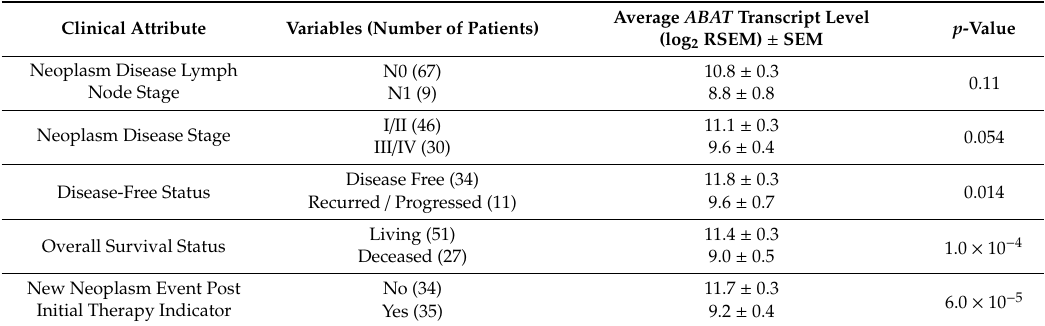
Table 2. Relationships between ABAT expression levels and clinical phenotypes.